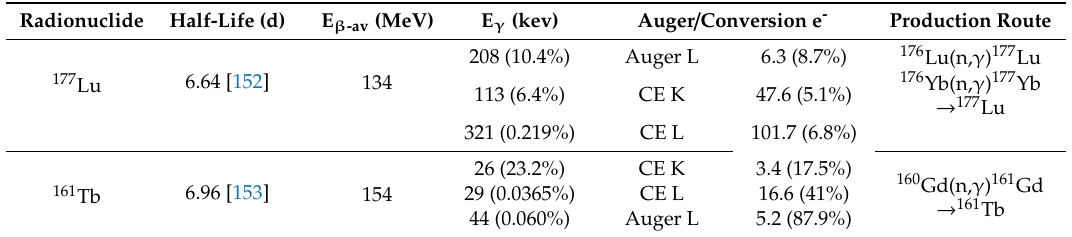
Table 6. Comparison of 177 Lu and 161 Tb decay characteristics and production routes (data are taken from [22]).